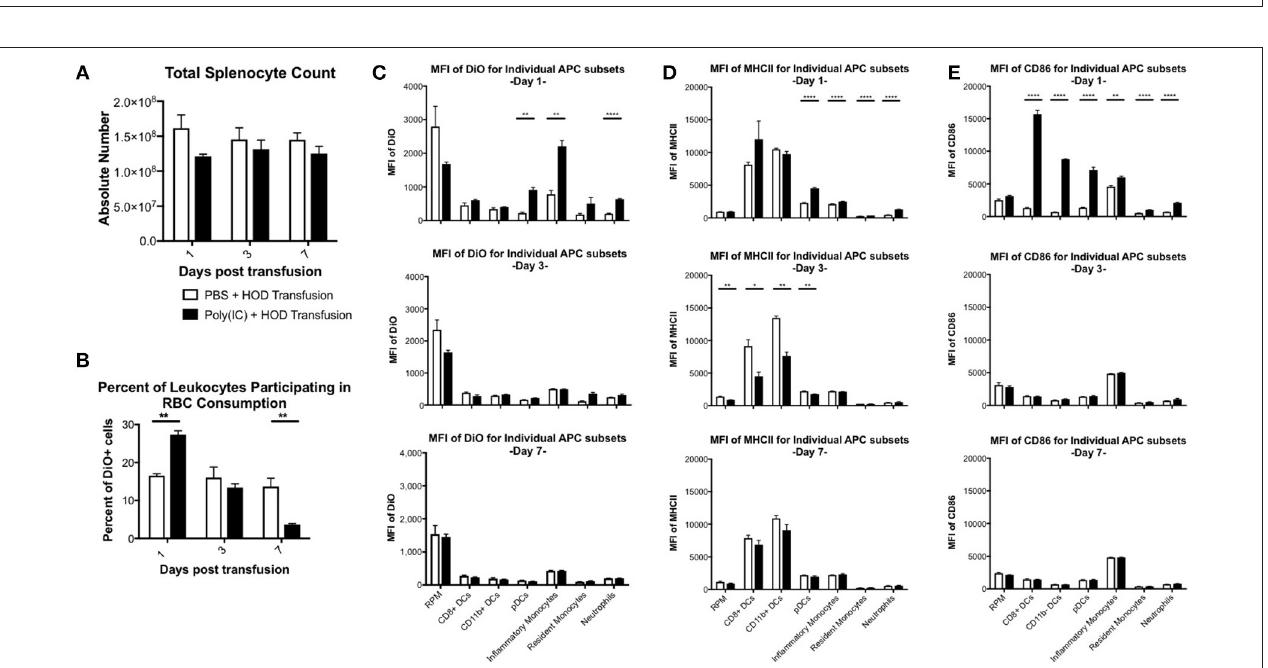
FIGURE 3 | Poly (I:C) leads to increased RBC consumption and upregulation of MHCII and CD86 expression. Recipient B6 mice were treated with poly (I:C) or control PBS and subsequently transfused with 100 uL of packed, leukoreduced, DiO-labeled HOD RBCs. At multiple time points, spleens were harvested, collagenase digested, and stained with antibodies to delineate APC subsets. (A) Total splenocyte counts were calculated and (B) the percent of DiO + leukocytes was determined. The MFI of (C) DiO, (D) MHCII, and (E) CD86 was assessed for individual APC subsets. These experiments were repeated 3 times with 3 mice per group with similar results. A representative experiment is shown. PBS treated animals are shown with an open bar and poly (I:C) treatment is shown with a solid black bar. For analysis, T cells, B cells, and RBCs were excluded from total live leukocytes by gating out cells positive for Thy1.2, CD19, NK1.1, CD49b, and TER119. The following phenotypes were used to delineate APC subsets: RPMs: CD11c − / lo CD11b − / lo F4/80 + ; CD8 + DCs: CD11c hi CD11b − CD8 + ; CD11b + DCs: CD11c hi CD11b + CD8 − ; pDCs: PDCA1 + CD11c int Ly6C hi ; inflammatory monocytes: CD11c − / lo CD11b + Ly6G − Ly6C hi CD115 + ; resident monocytes: CD11c − / lo CD11b + Ly6G